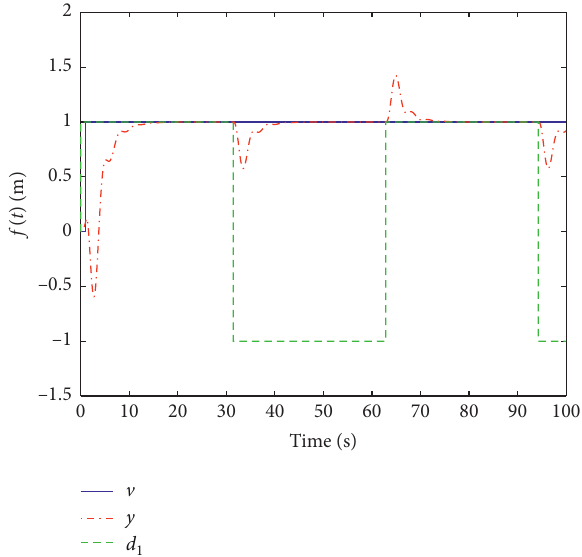
Figure 15: Control system response with disturbance signal d